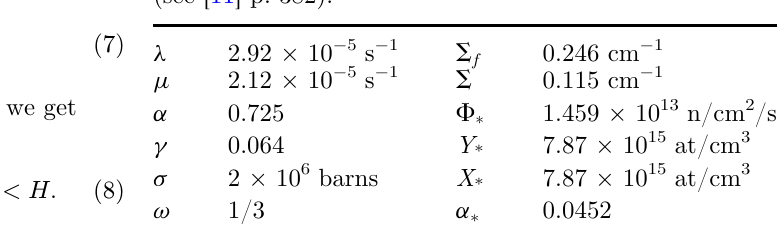
Table 1. Typical numerical data for our one-group model (see [11] p.